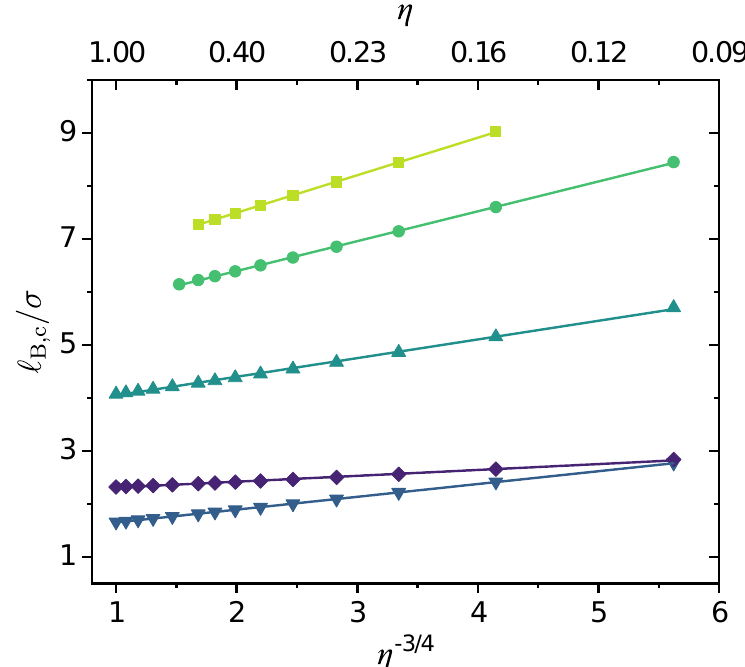
Figure 10. The scaling relationship: (cid:96) B,c ∼ η − 3/4 . The values for the following parameters were fixed: N T = 10 4 , N 1 = kN T η − 1, and (cid:101) A = (cid:101) B = (cid:101) AC = 0. Values for η is were varied, and therefore values for the N 1 -parameter were varied as well. From top to bottom: (i) N 1 = 0 ( k → 0), Z p = − 1, Z C = + 1; (ii) k = 1/4, Z p = − 1, Z C = + 1; (iii) k = 1, Z p = − 1, Z C = + 1; (iv) k = 1, Z p = − 2, Z C = + 1; (v) N 1 = 0, Z p = − 1, Z C = +